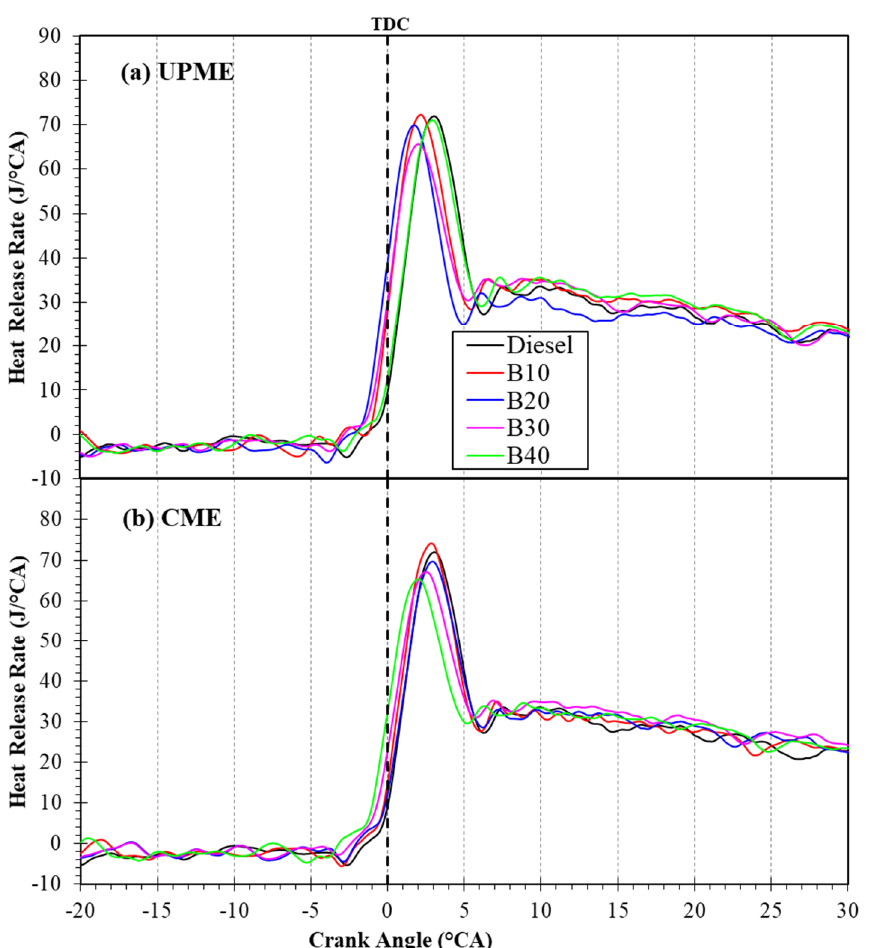
Figure 4. Heat release rate in terms of crank angle for ( a ) UPME and ( b ) CME fuel blends as compared to standard diesel.